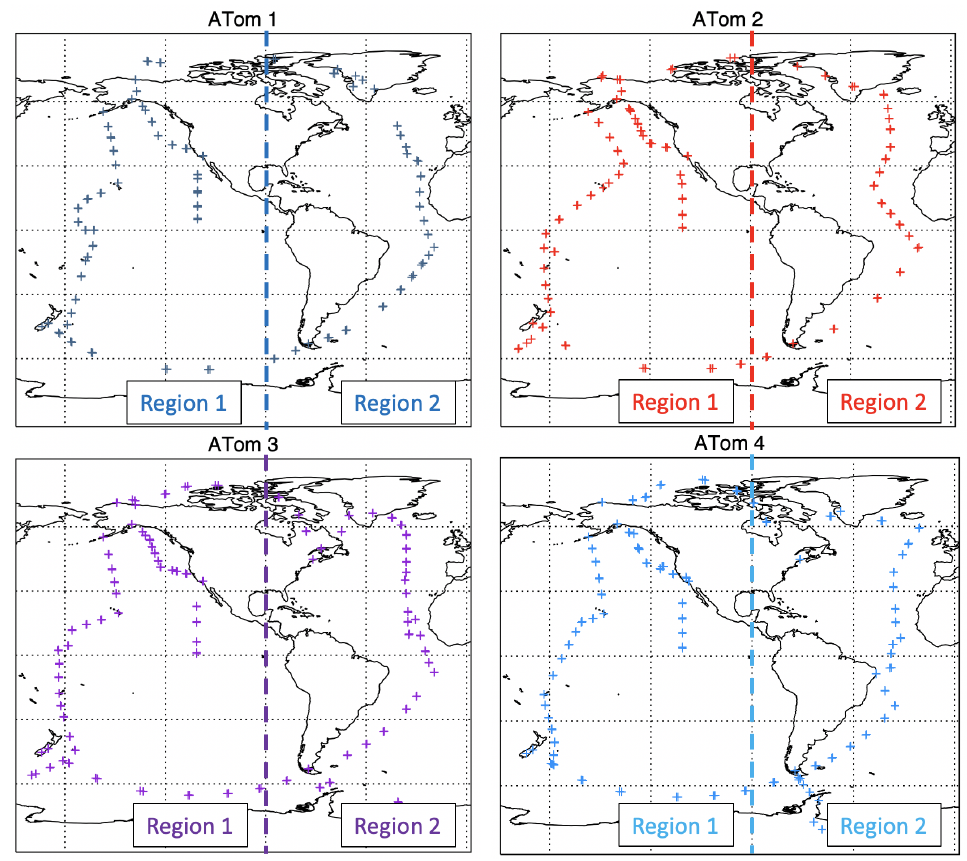
Figure 1. Locations of 500mbar pressure in aircraft profiles measured during the ATom campaigns. The vertical line at 60 ◦ shows the separation into Region 1 (Pacific) and Region 2